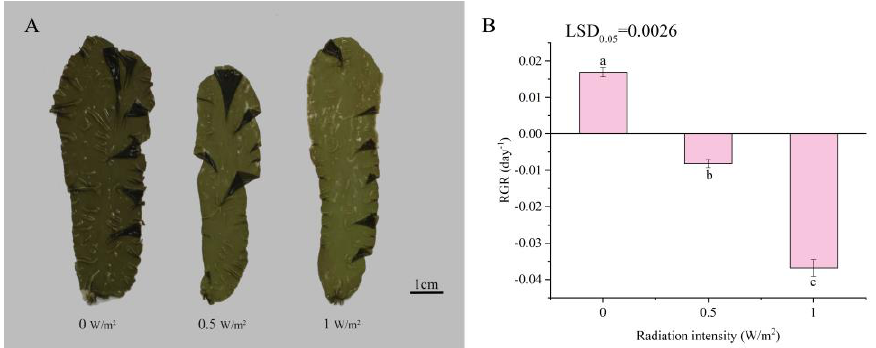
Figure 1. Changes in the morphology ( A ) and relative growth rate ( B ) of Porphyra haitanensis under different UV-B radiation intensities. Error bars are standard deviations ( n = 4). Columns with different letters are statistically different ( p < 0.05).